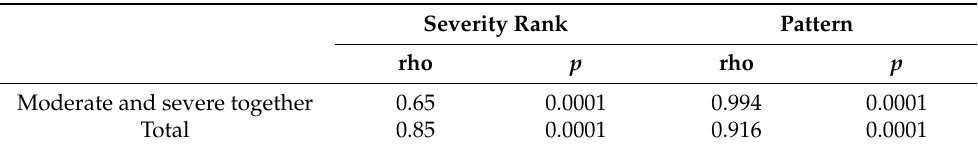
Table 4. Spearman correlation of the severity ranks and the predefined patterns (see text) of the two consecutive polygraphic examinations. Severity Rank Pattern rho p p Moderate and severe